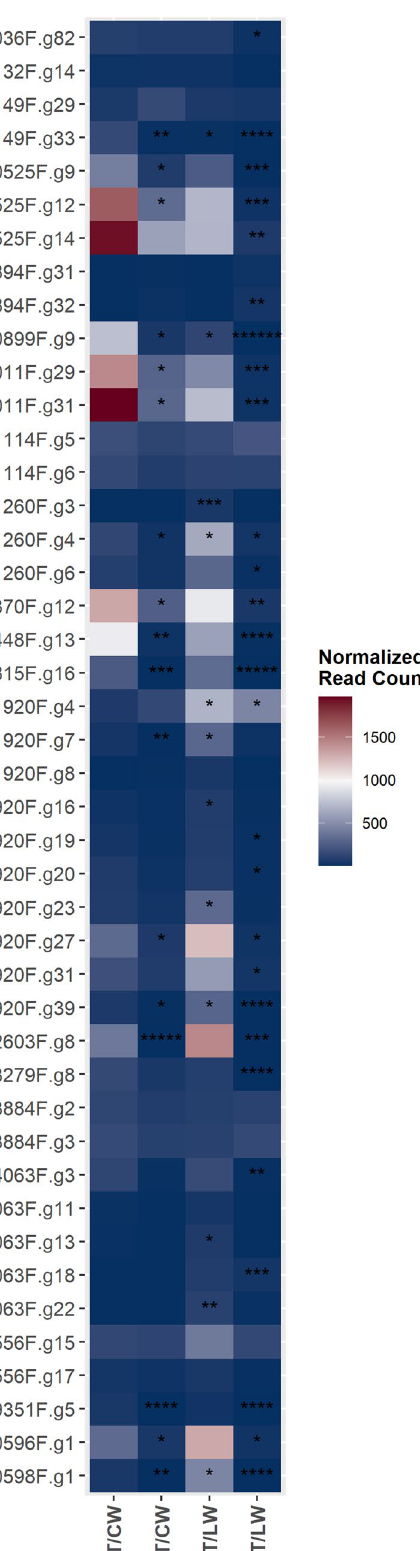
Figure 4. A heatmap of normalized read counts for transcripts putatively within the GO:0010333, terpene synthase activity. Asterisk (*) indicate the log2-fold change: * > 2 log2-fold change, ** > 4 log2-fold change, *** > 6 log2-fold